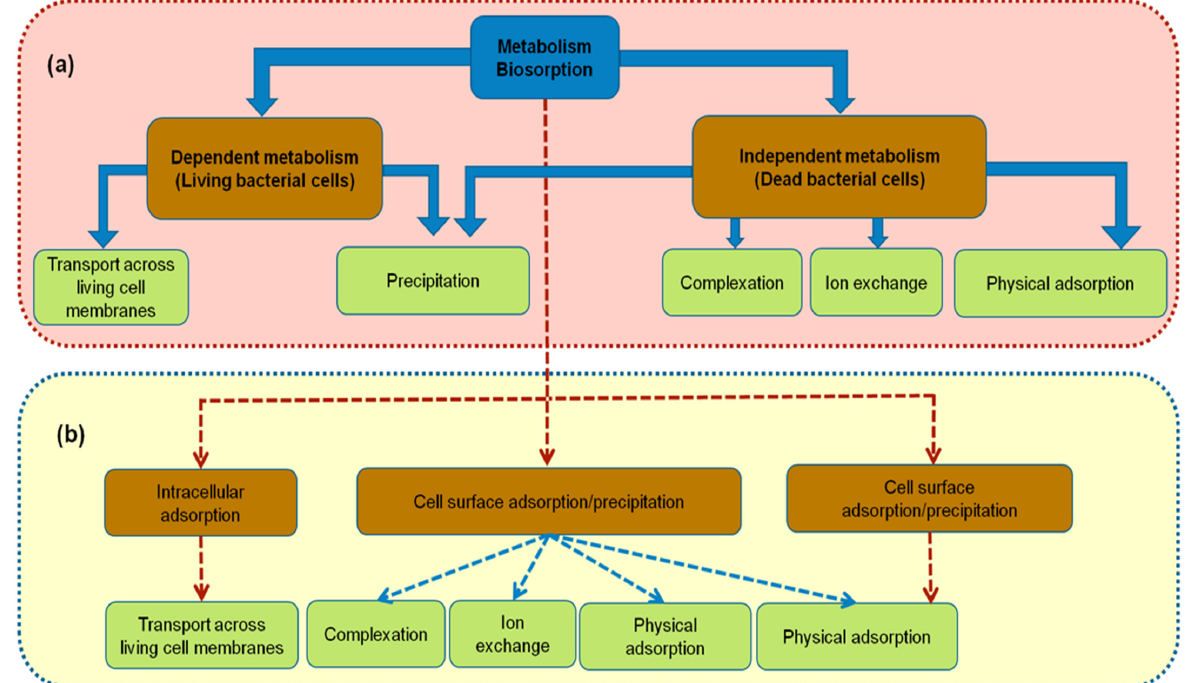
Figure 1. Mechanisms of bacterial biosorbent: ( a ) on cell surface; ( b ) within the cell where the HMs are removed.